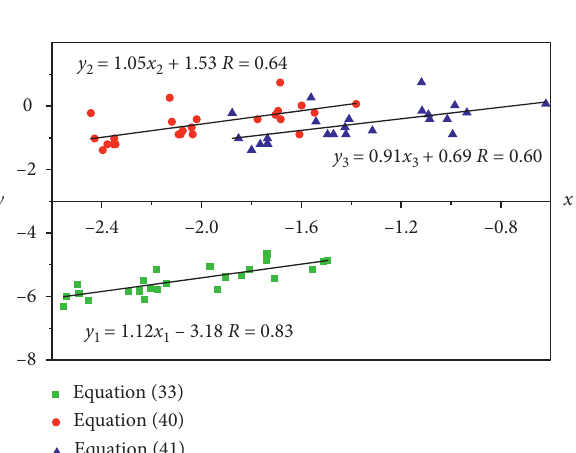
Figure 10: Fitting results of the attenuation law of vibration peak in